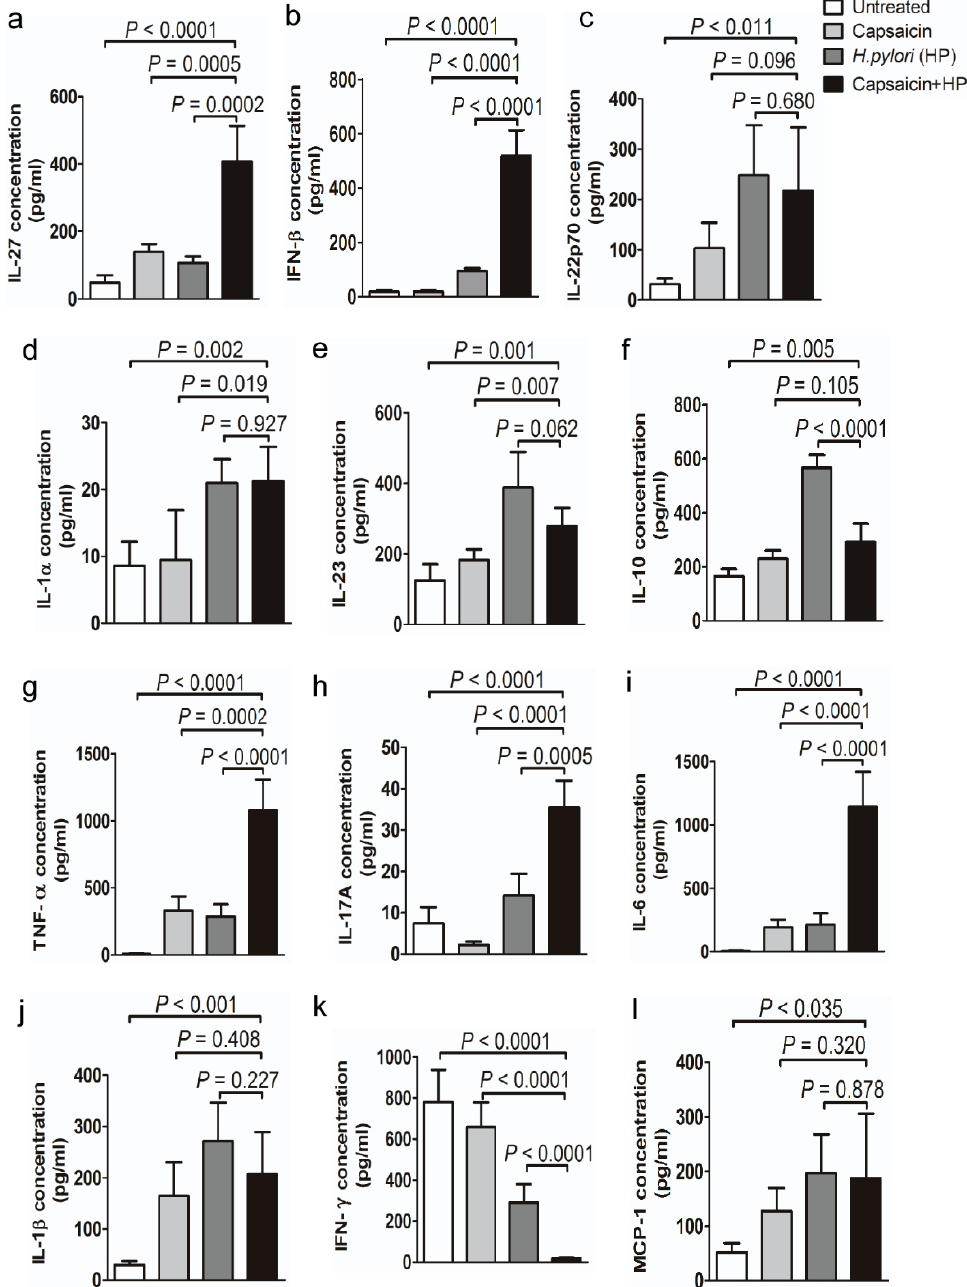
later gastric cancer.